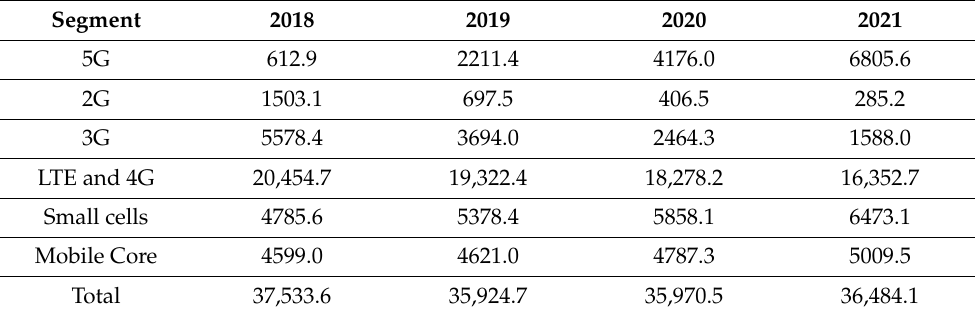
Table 1. Wireless Infrastructure Revenue Forecast, Worldwide, 2018–2021 (Millions of